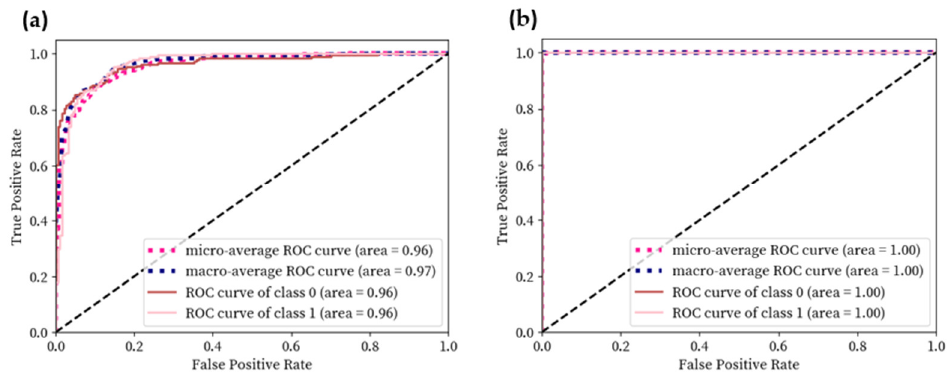
Figure 11. The confusion matrix of classification. ( a ) Two-class classification of original images; ( b ) two-class classification of generated images.